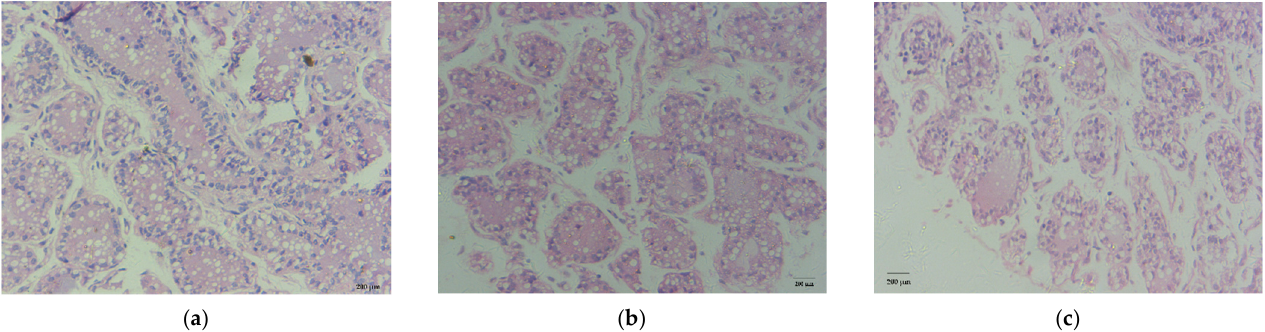
Figure 1. Histological sections stained with HE. ( a ) Dairy cow mammary tissue collected at 90 d of lactation. ( b ) Dairy cow mammary tissue collected at 180 d of lactation. ( c ) Dairy cow mammary tissue collected at 270 d of lactation. Table 2. The acinus area, lipid droplets area, and number of nuclei in an acinus.